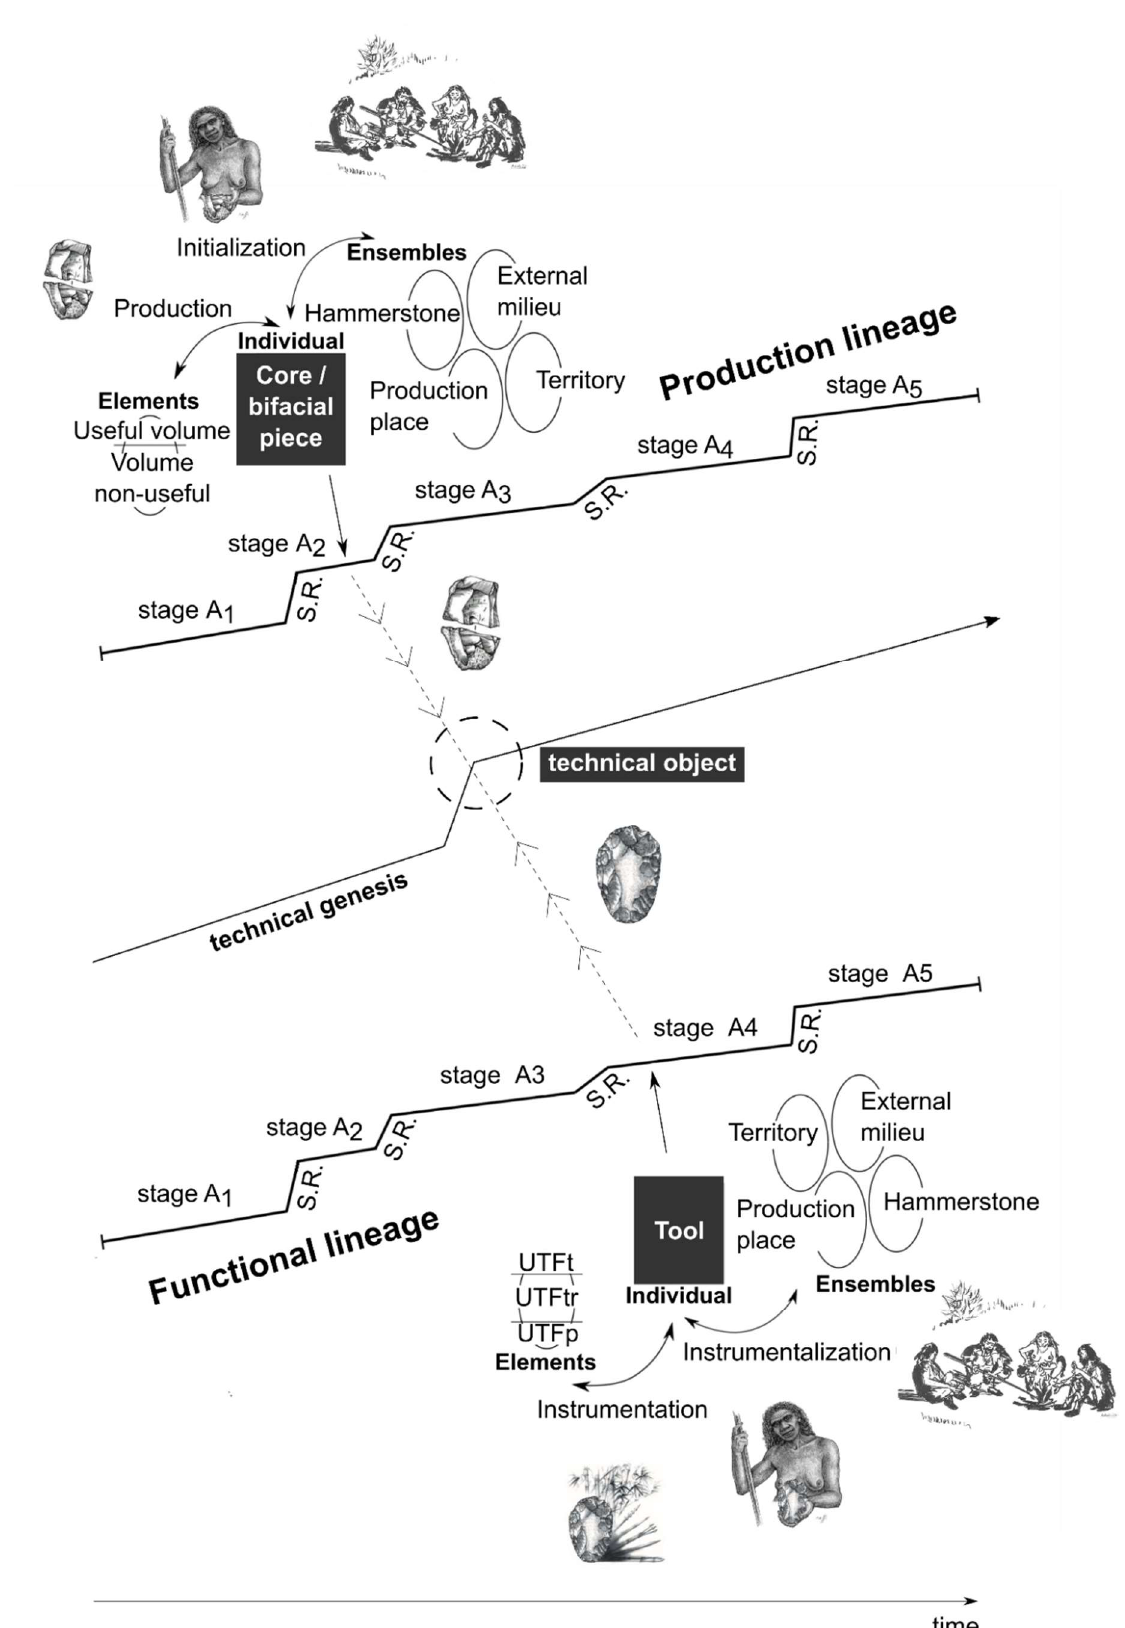
Figure 14. Structure of technical lineages in prehistory: The lineages of production and function are independent at one point in the analysis, but must then be addressed together in an attempt to understand technical genesis. Drawings by Maxence Raffi, Hubert Forestier and Aurore de